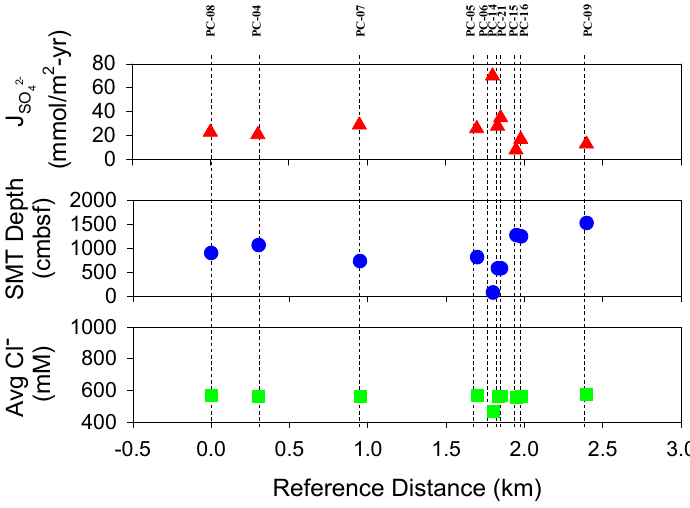
Figure 6. Estimated SMT depths, sulfate diffusion rates ( (cid:1836) concentrations over a 3 km transect across the suspected seep feature shown WesternGeco seismic profile for Inline 986 (Figure 2). Distances are referenced to AC-07 PC-08. Core PC-06 contained solid phase hydrates which destabilized during